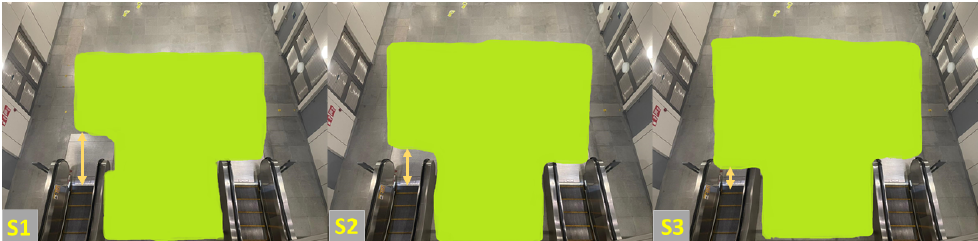
Figure 16. Generated track map after each trail from various starting points (S1 starting point 1, S2 starting point 2, and S3 starting point 3) near escalator of scenario-2 ascending direction wherein the green pixels represent the robot-covered region, and yellow arrow represents the distance between the covered region and escalator’s first